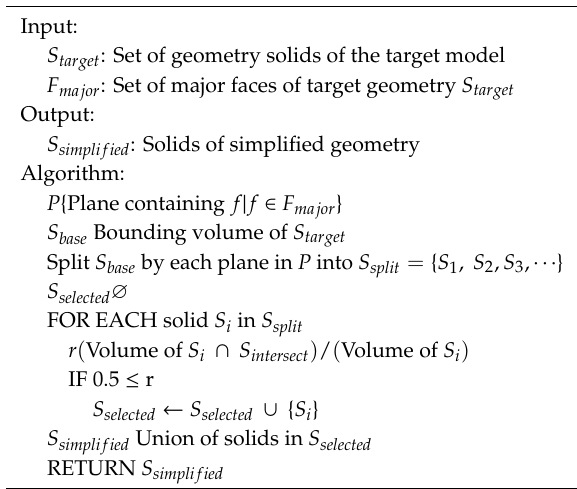
Algorithm 2 Pseudocode for polyhedron